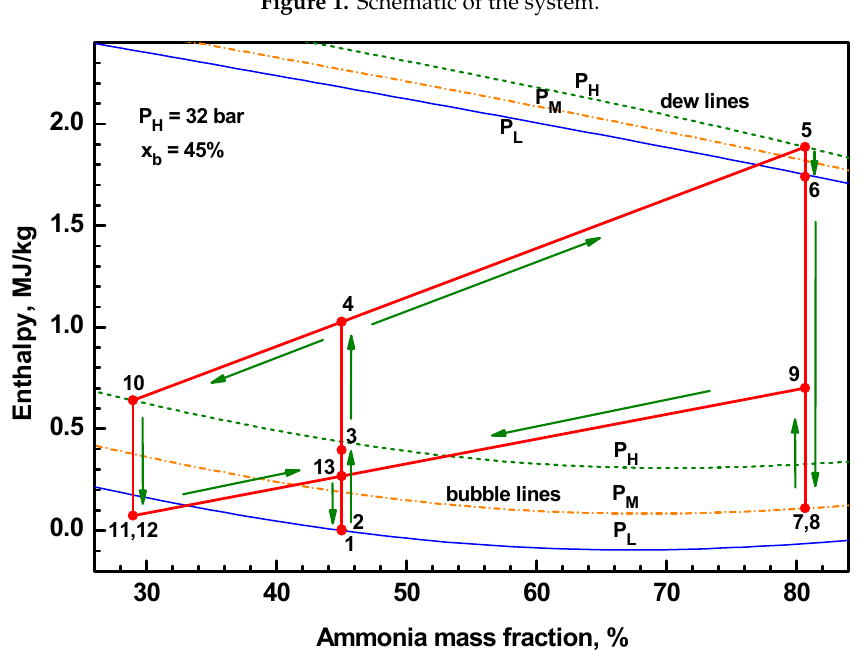
Figure 1. Schematic of the system.